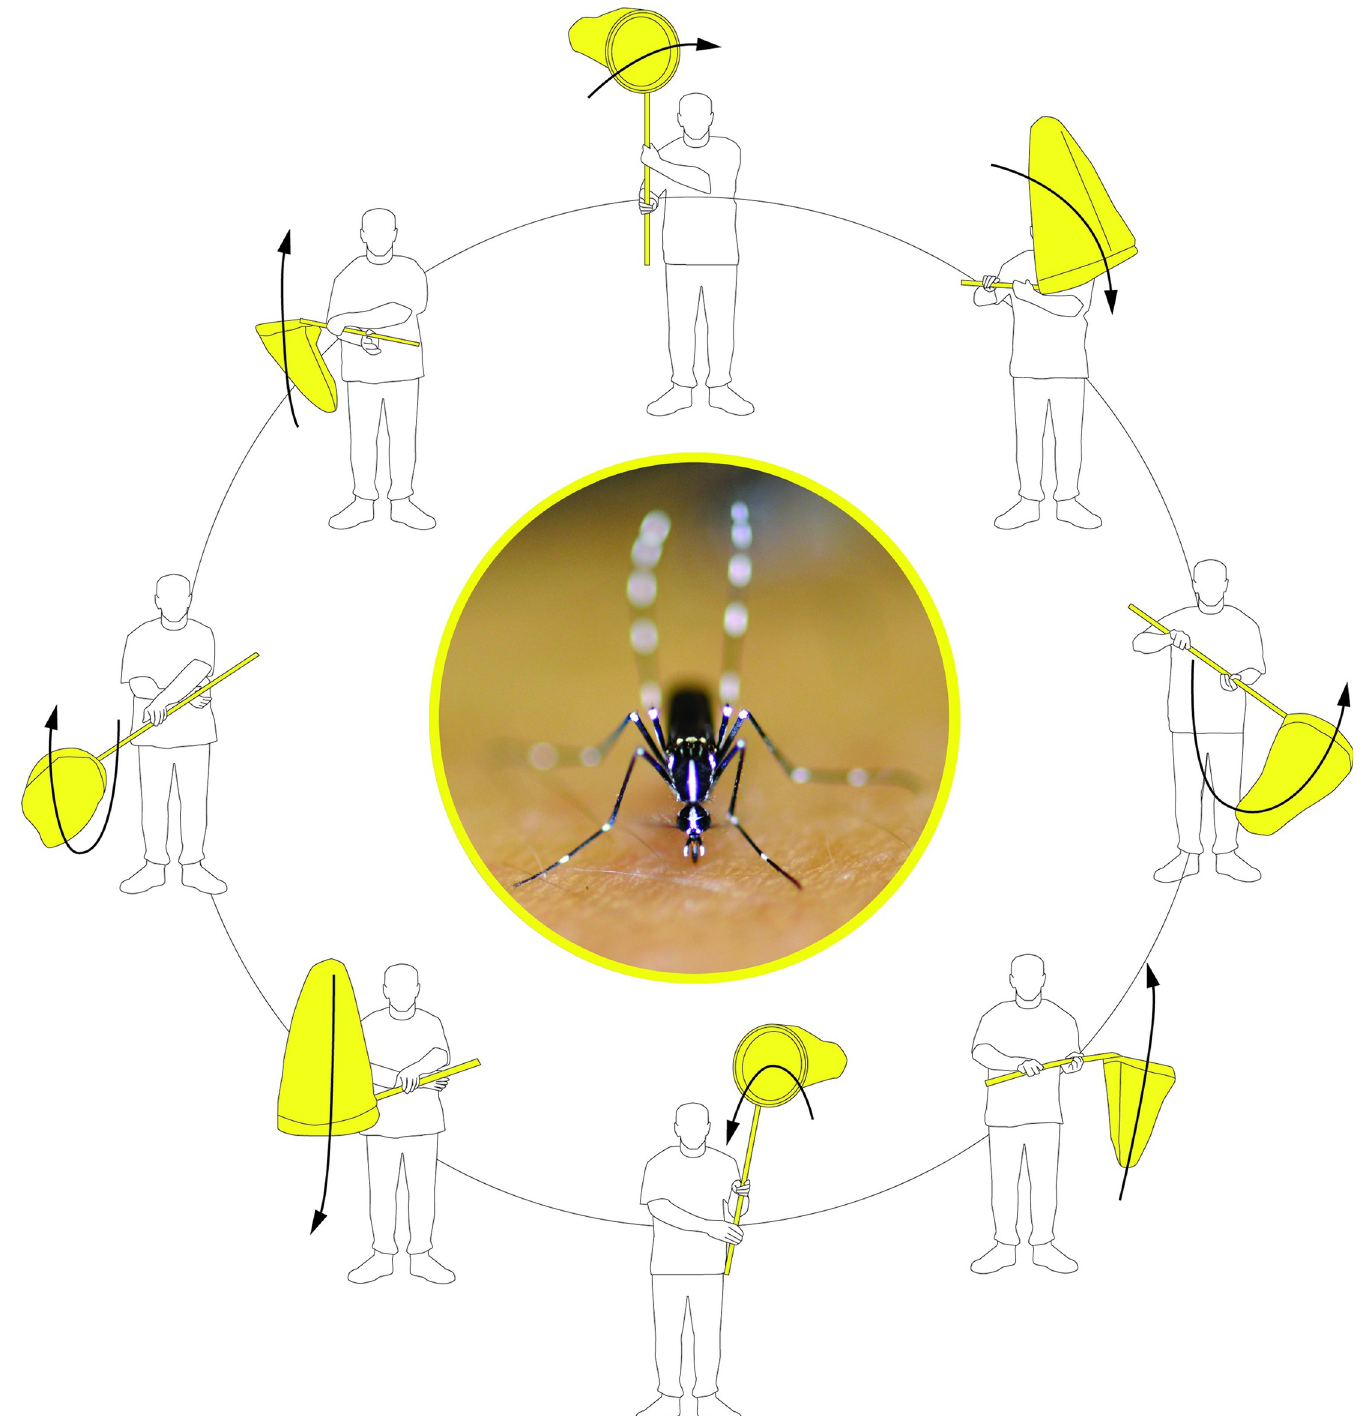
Fig 1. Diagrammatic representation of individual performing human sweep net surveillance using a butterfly or “Fig eight” pattern.